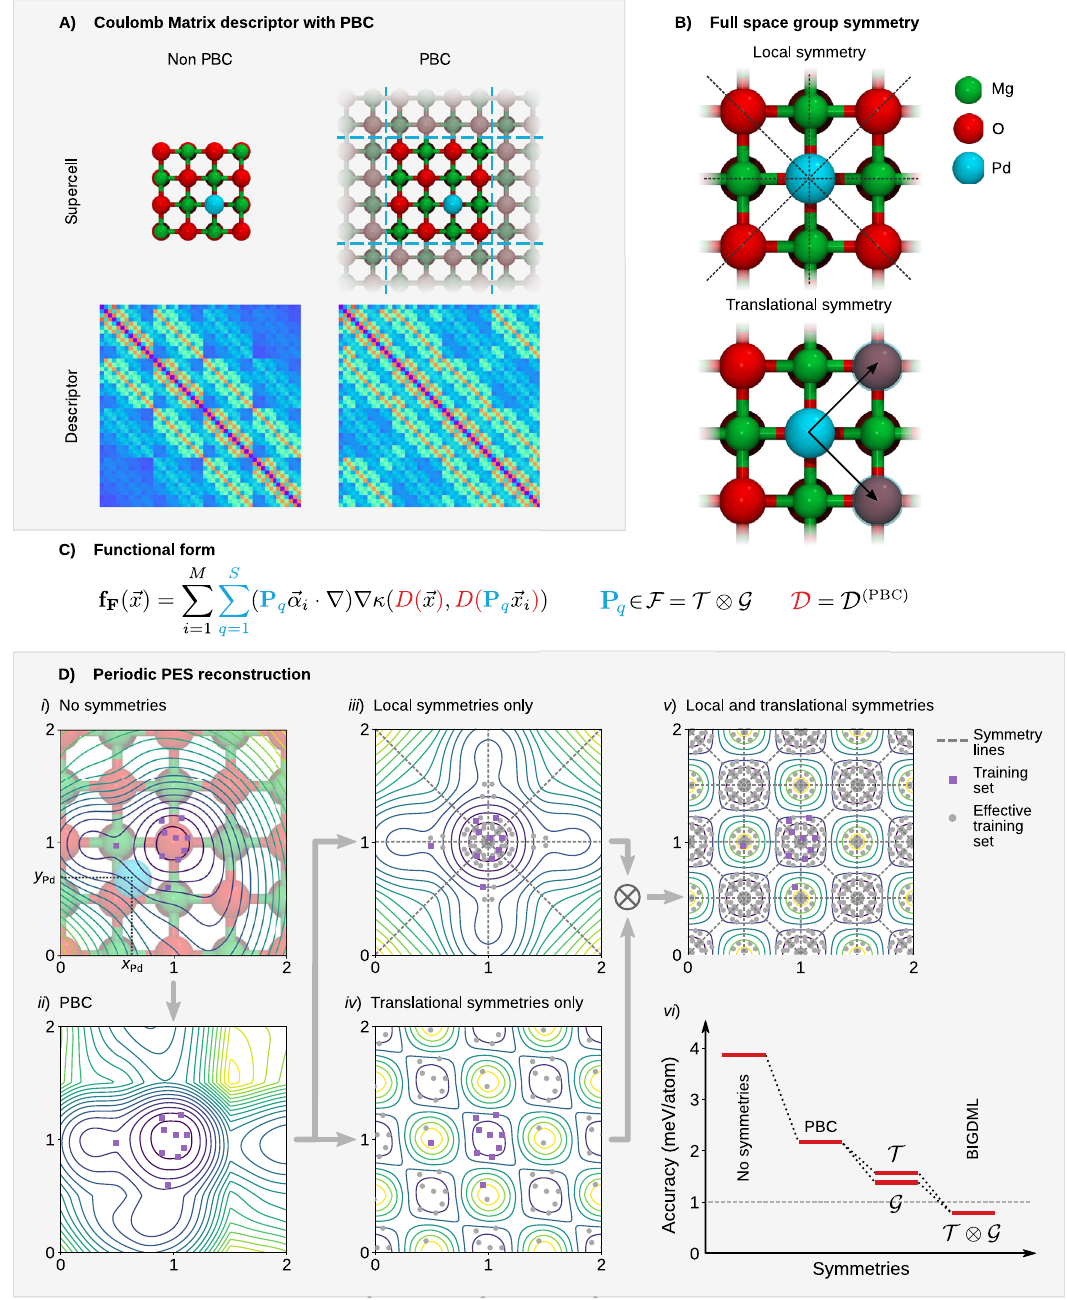
Fig. 1 The BIGDML model. A Coulomb Matrix representation for non-periodic (left) and periodic (right) supercell (2 × 2 × 3L) of Pd 1 /MgO(100). B Description of the local symmetries (i.e. Bravais group G or point group of the unit cell) and the translation symmetries of the unit cell T . C Analytical form of the sGDML predictor, where the explicit usage of the full symmetry group of the supercell F (in blue) and the Coulomb matrix PBC descriptor (in red). D Systematic symmetrization of the PES. The axis in the PES are the x and y coordinates of the Pd atom (purple squares) in units of the lattice constant of MgO. Models: (i) Pure GDML, (ii) GDML + D ð PBC Þ , (iii) sGDML + D ð PBC Þ (s = G ), (iv) sGDML + D ð PBC Þ (s = T ), and (v) BIGDML. The gray arrows indicate the order in which each symmetry was applied, and the panel shows its effect on the PES. (vi) displays the incremental accuracy upon addition of each symmetry for the Pd 1 /MgO (100) system. All models used for this comparison were trained on 50 data